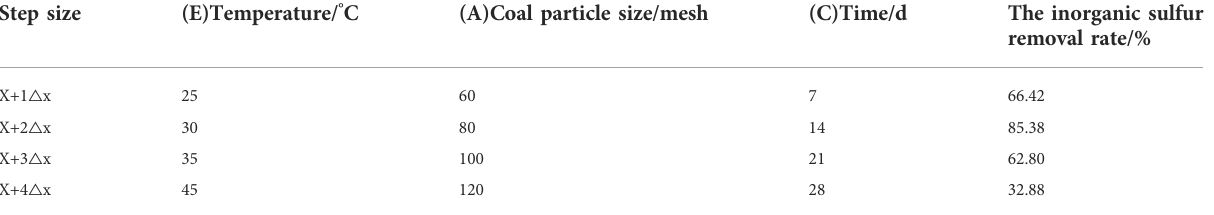
TABLE 5 Steepest climbing experiment